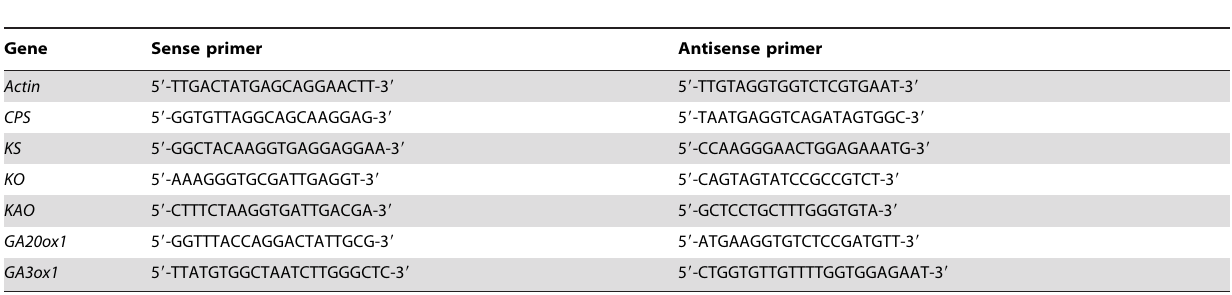
Table 1. Primers designed using Primer 5.0 software and used to real-time PCR analysis of CPS , KS , KO , KAO , GA20ox1 and GA3ox1